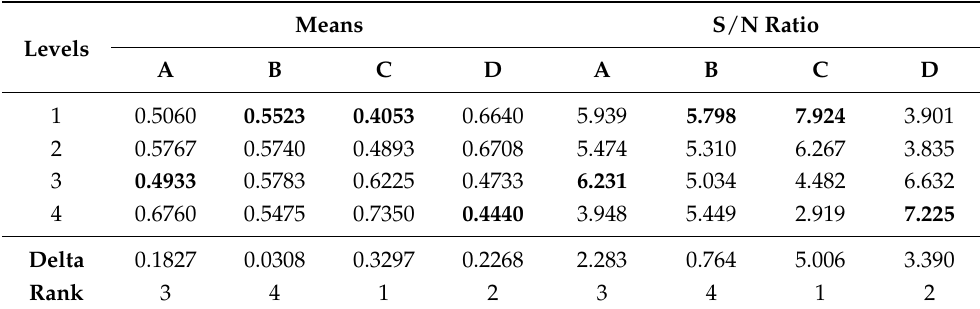
Table 3. Response table for means and S/N